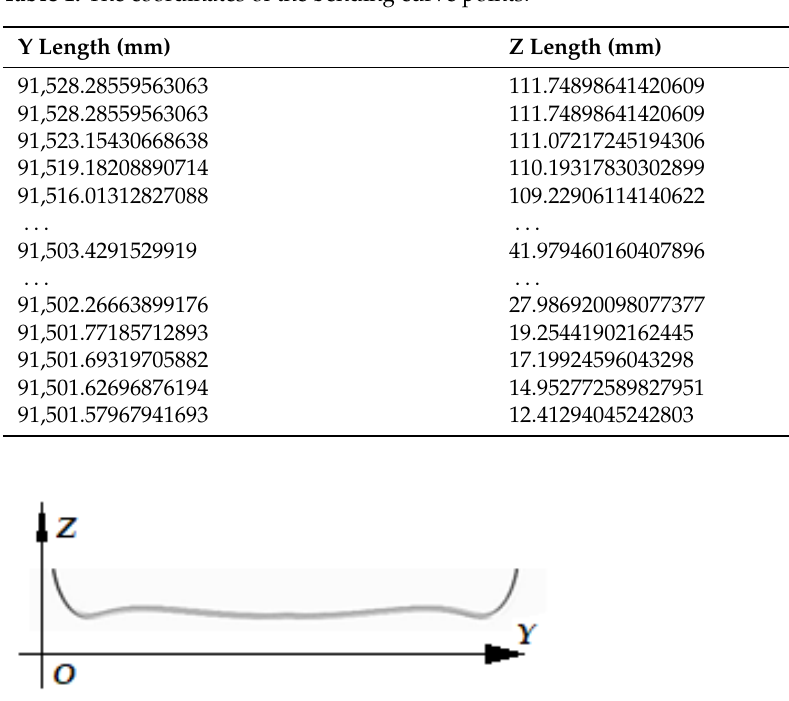
Figure 24. The curve drawn by the mechanism.